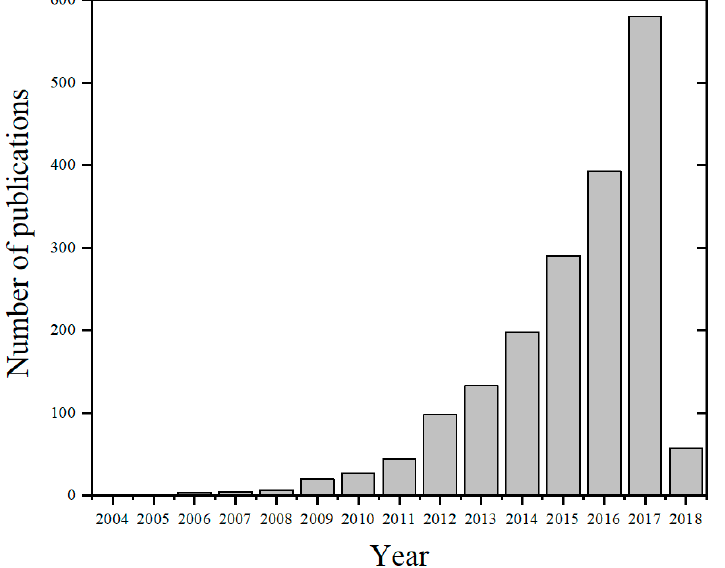
Figure 1. Number of publications based on a web of science search for the phrase “deep eutectic solvent”. Date accessed: 10 February 2018.